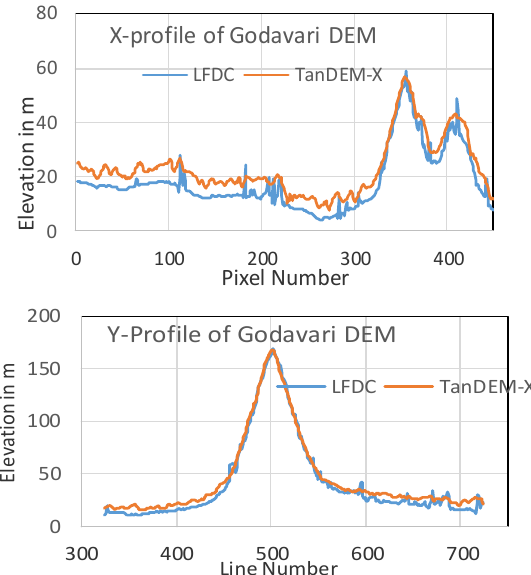
Figure 7. Elevation trend for aerial LFDC and TanDEM-X DEMs for Godavari test site at a particular location in X- and Y-direction of the image.